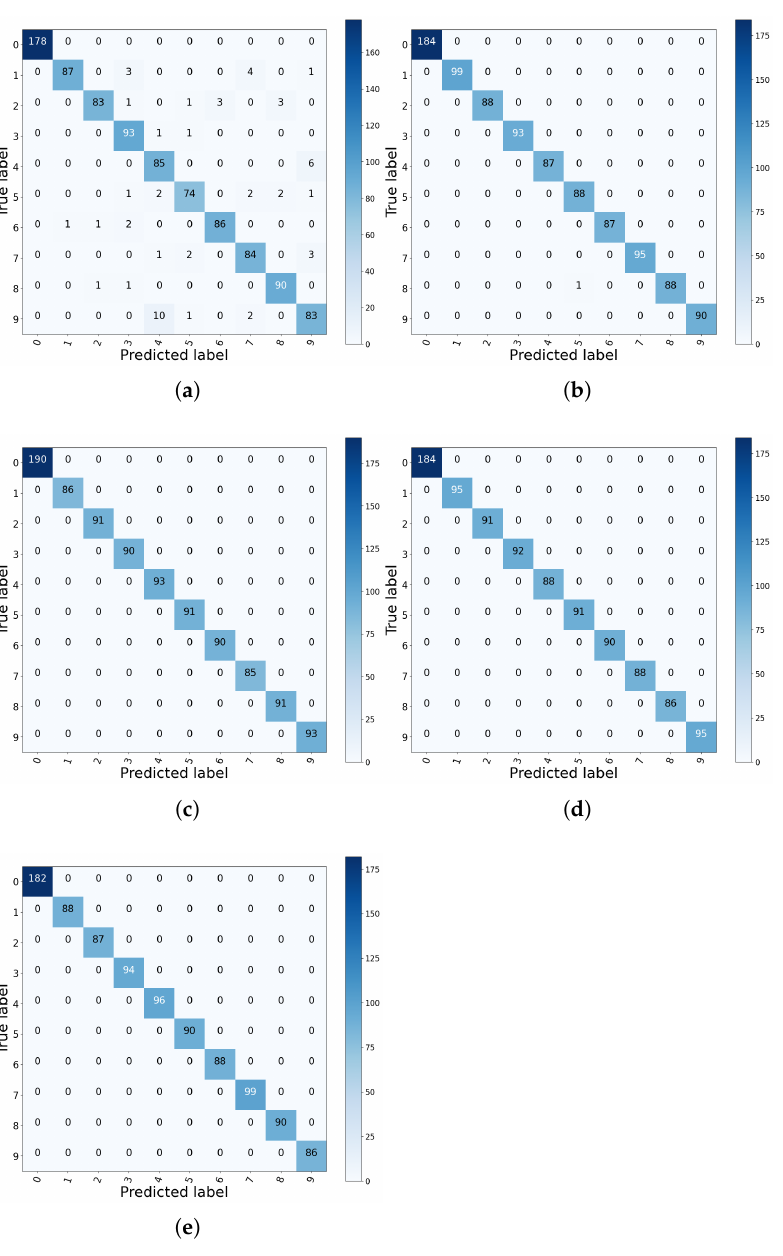
Figure 5. Confusion matrix of the CWRU dataset. ( a ) MLP; ( b ) CNN; ( c ) SimpleIMSCNN; ( d ) MSCNN; ( e )